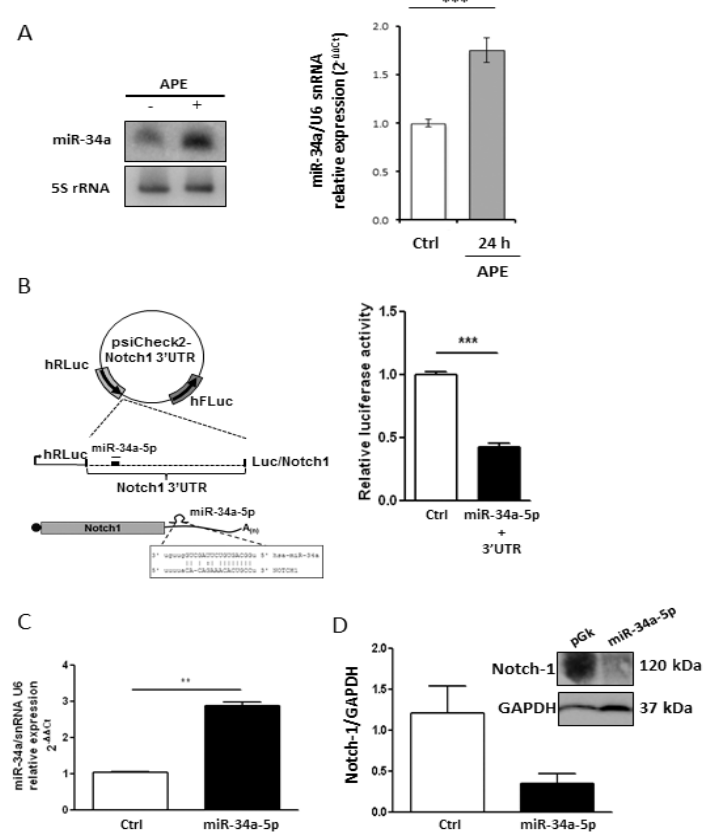
Figure 3. Analysis of Notch-1/miR-34-5p interaction. ( A ) Analysis of miR-34a-5p expression in U87MG cells, treated with 100 µ M APE, by Northern blot (left) and real time RT-PCR (right) (*** p < 0.001 t -test); ( B ) Upper scheme: representation of Luc/Notch reporter construct. MiR is indicated as a thin line, miRNA response element as a thick line. Lower scheme: representation of 3 (cid:48) UTR region (with related sequences) binding mir-34a-5p. Right panel: luciferase activity (Renilla/Firefly ratio) of Notch-1 3 (cid:48) UTR reporter gene in HEK293 cells transfected for 48 h with the mir-34a-5p expressing vector or with empty vector used as control (Ctrl). Data are presented as mean ± SD from at least three different experiments. (*** p < 0.001 t -test); ( C ) mir-34a-5p over-expression after transfection in U87 cells (** p < 0.01 t -test); ( D ) Western blot analysis for Notch-1 levels in U87MG cells transfected with mir-34a-5p.